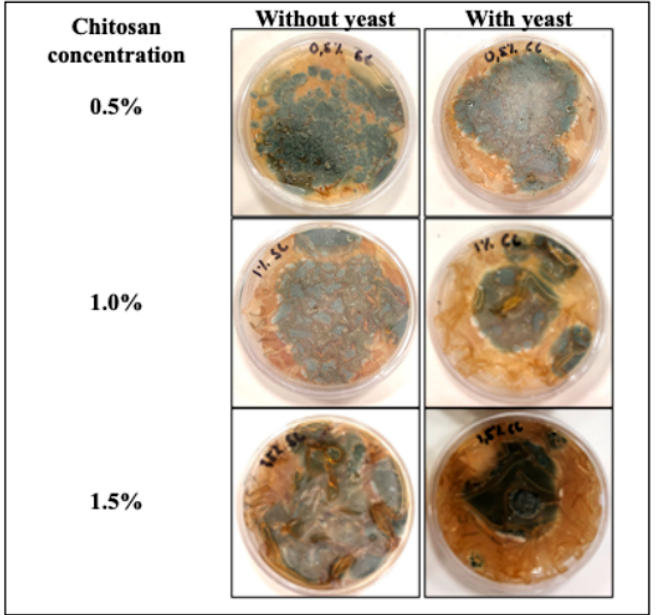
Figure 1. Mycelial development of Penicillium italicum exposed to chitosan ‐ based films for 6 days.